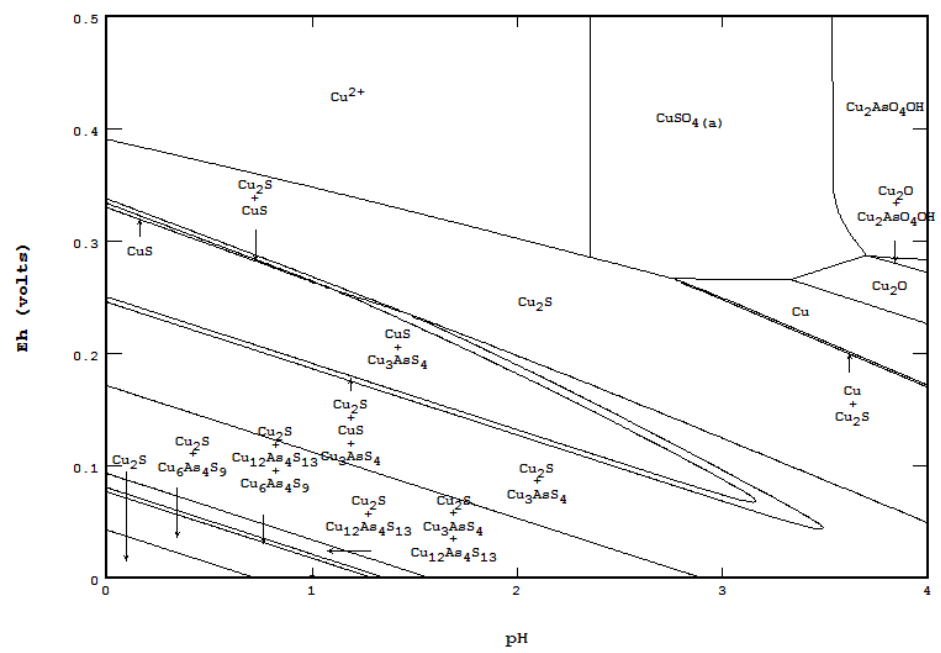
Figure 15. Mass balanced Eh-pH diagram for the enargite Cu 3 AsS 4 system. The mass ratio is 0.75:0.25:1 for Cu, As and S. The diagram shows only the copper species in acid solution.